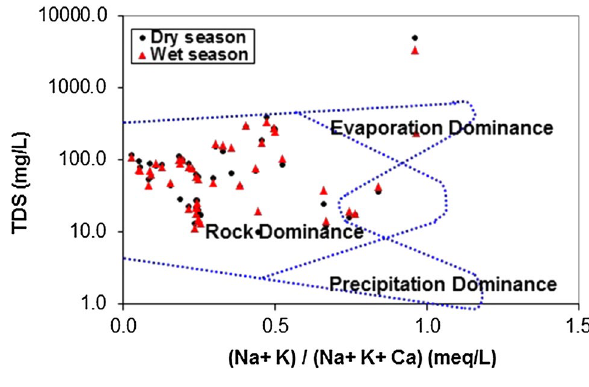
Fig. 5 Gibbs plot of cation